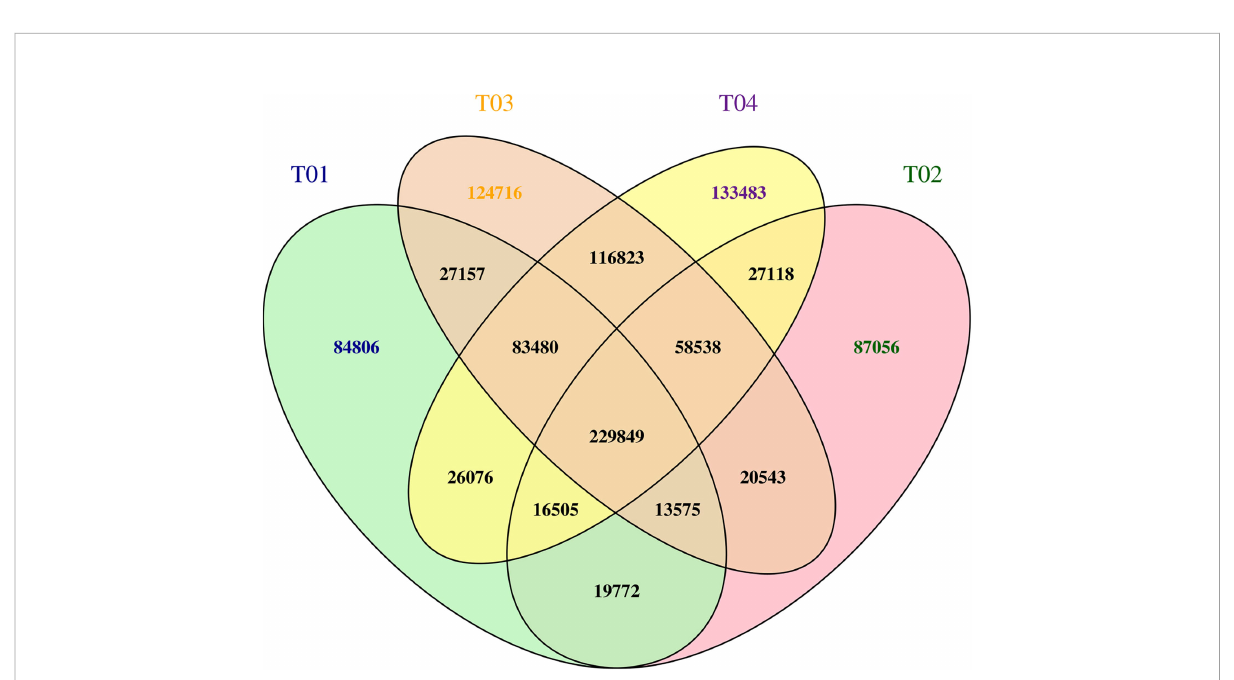
FIGURE 5 A Venn plot of SNP statistics for T01, T02, T03, and T04. The numbers of SNPs are